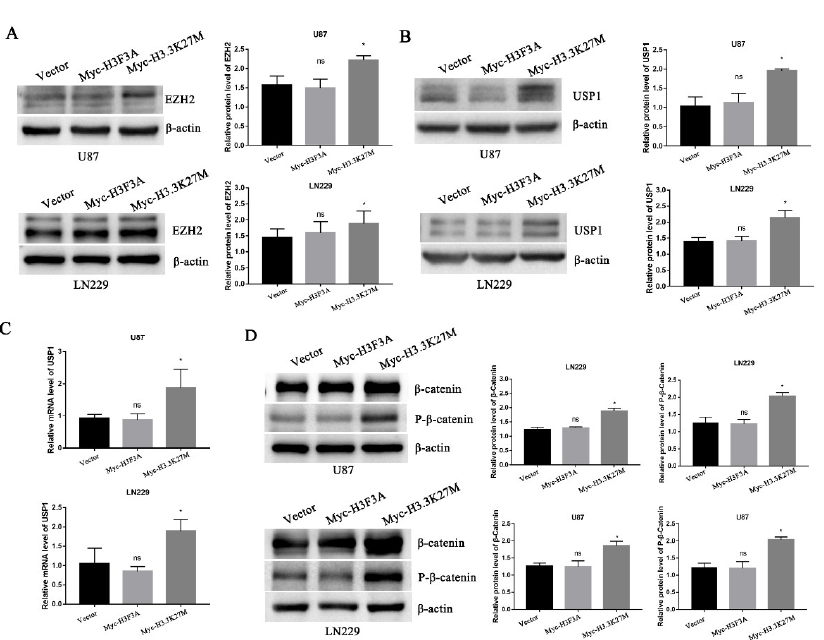
Figure 5. Western blotting and RT-PCR showed that H3.3K27M regulated the β -catenin/USP1/EZH2 signaling pathway. ( A ) Representative blots and statistical graph of the H3.3K27M-induced